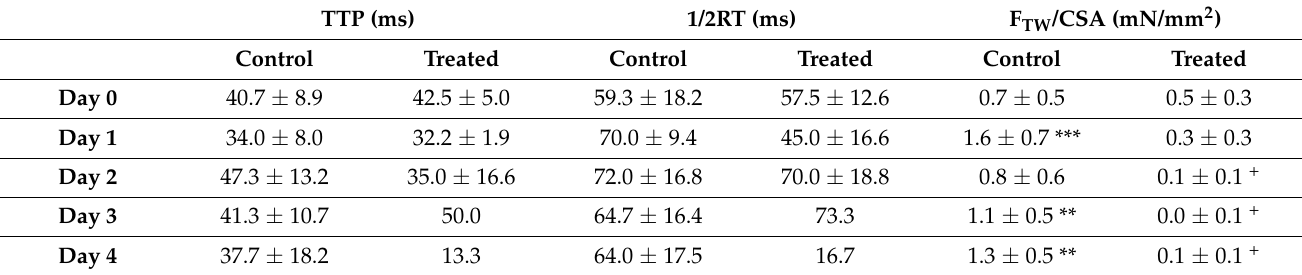
Table 1. Kinetic contractile parameters (TTP and 1/2RT) and specific twitch force (F TW /CSA) in control and treated X-METs for the five days of acquisition. Values are mean ± SD. n = 5 for control X-MET, n = 4 for treated X-MET. *** p -value < 0.001, ** p -value < 0.01 vs. treated X-METs (from two-way ANOVA). + p -value < 0.05 vs. day 0 (from one-way ANOVA). 1/2RT (ms) F TW /CSA (mN/mm 2 )